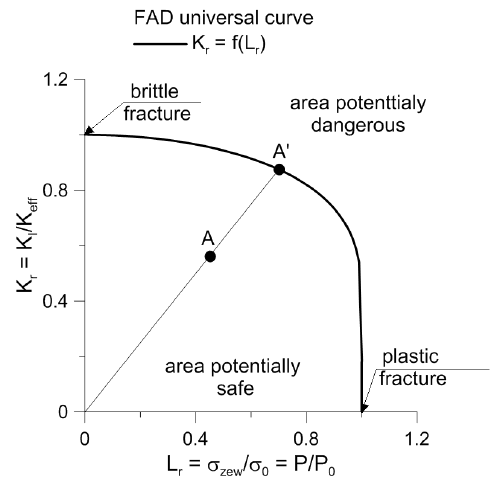
Figure 2: Failure assessment diagram (developed by the author on the basis of [11,